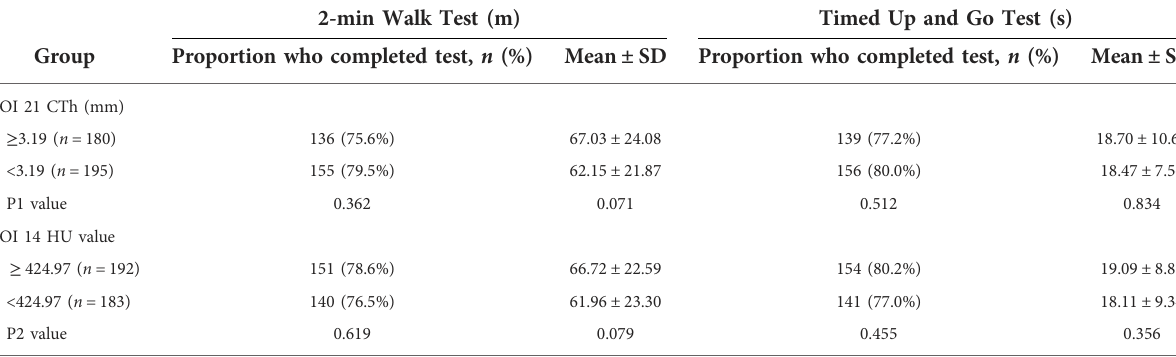
TABLE 7 Performance-based functional ability by the group measured using the 2-min walk test and Timed Up and Go test.